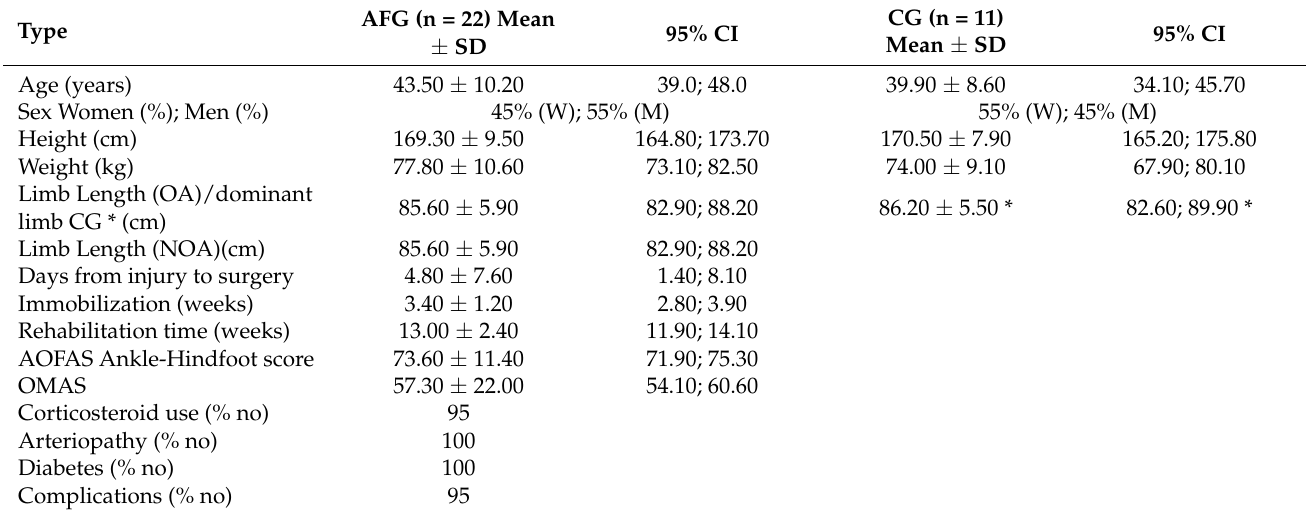
Table 1. Demographic, anthropometric, clinical, and functional characteristics of patients with bimalleolar ankle fractures 6 months after surgery and the control group.